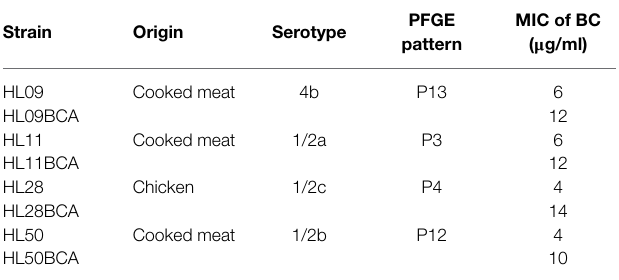
TABLE 1 | Listeria monocytogenes strains used in this